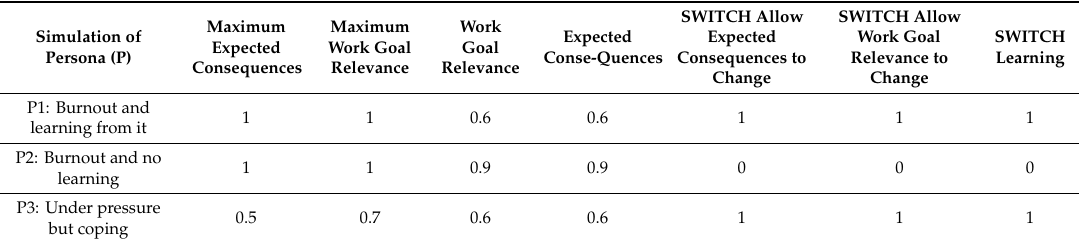
Table 2. Parameterization of the scenario runs, simulating the e ff ect of three di ff erent personas (P) on the development of burnout and recovery. Runs are performed by a combination of parameter changes in policy values, initial states, and